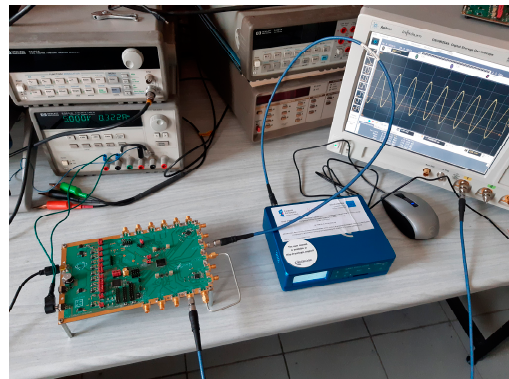
Figure 26. CCNV1-A1 measurement environment with the evaluation board. The photo presents the CCNV1-A1 measurement board connected to the LabSat 3 GNSS Simulator and DSO90254A Digital Storage Oscilloscope.